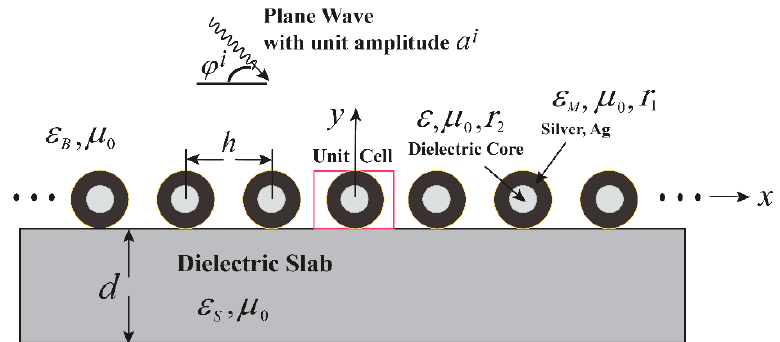
Figure 5. Cross-sectional view of the plasmonic grating composed of Ag-coated dielectric nanocylinders periodically arranged on a dielectric slab with thickness d . Material parameters of the background medium, the coating metal, the dielectric core, and dielectric substrate were ( ε B , µ 0 ) , ( ε M , µ 0 , r 1 ) , ( ε , µ ) , and ( ε s , µ ) , respectively. The excitation was provided by an impinging H -polarized plane wave with an incident angle ϕ i .